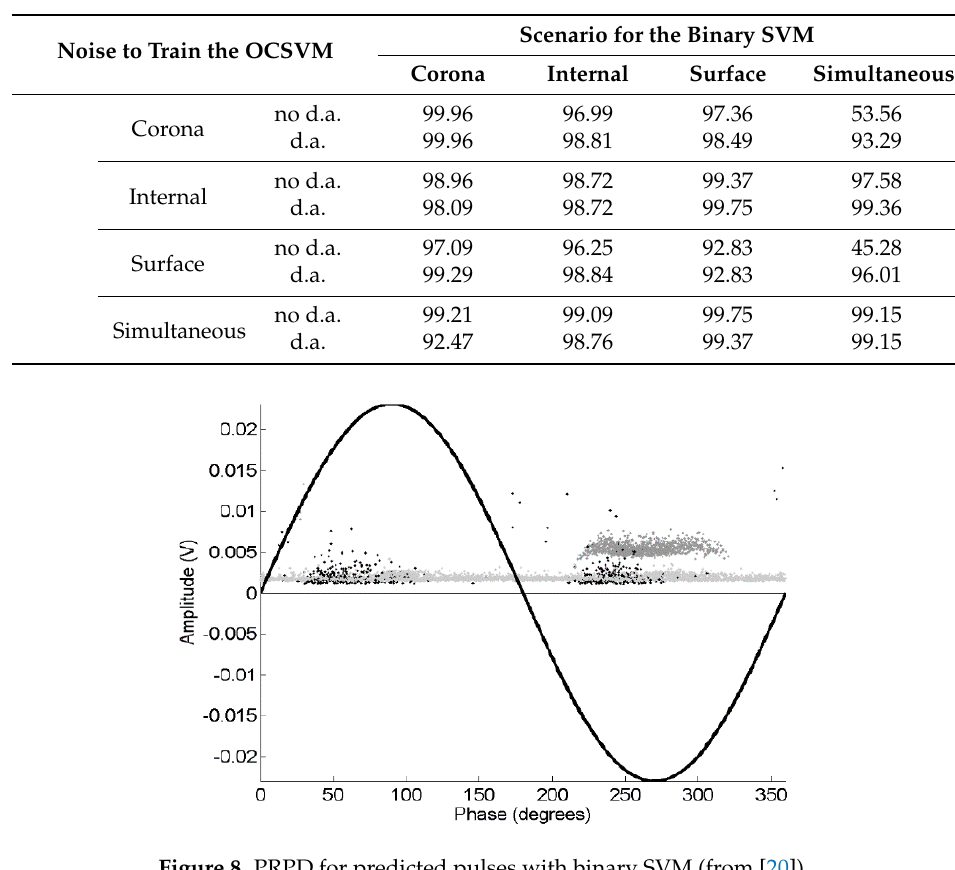
Table 4. Agreement (percentage of times in which both classifications coincide) between the OCSVM and a binary SVM trained with data collected in the scenario corresponding to the test set. In order to align the classifications of both methods, we compute as one agreement when either both OCSVM and SVM classify the same test pulse as noise or when the SVM classifies it as PD and the OCSVM as not-noise. Any other situation counts as a disagreement. The top number in each cell indicates the agreement when the bias term of the OCSVM ρ is the output of the optimization of (2) subject to (3) and (4). The bottom number is the agreement when ρ is further refined using an extra training set of noise recorded from the same scenario of the test data but not included in the test set. The test data includes pulses of noise and PD.